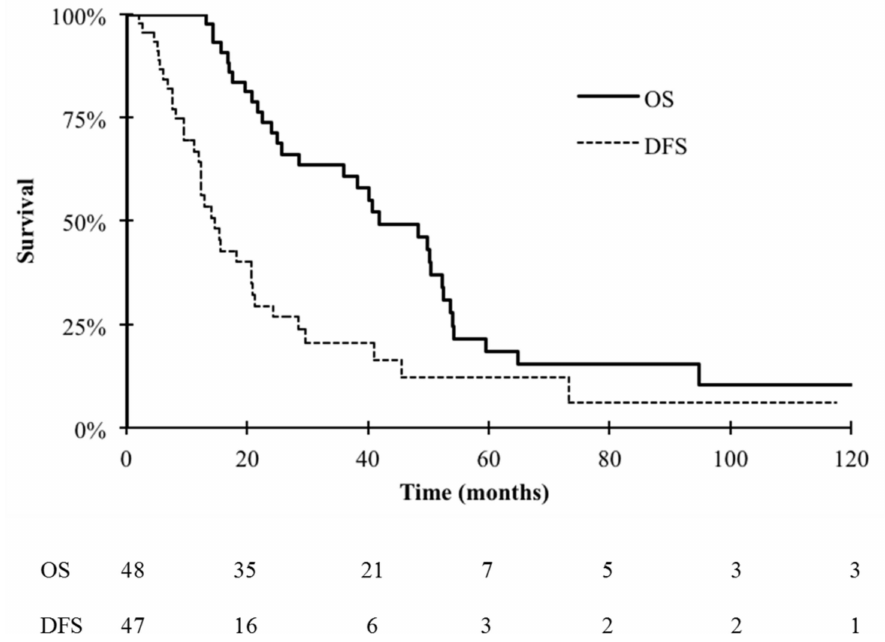
Fig 2. Overall (OS) and disease-freesurvival (DFS) after complete cytoreductive surgery in patients with DSRCT without extra-peritoneal